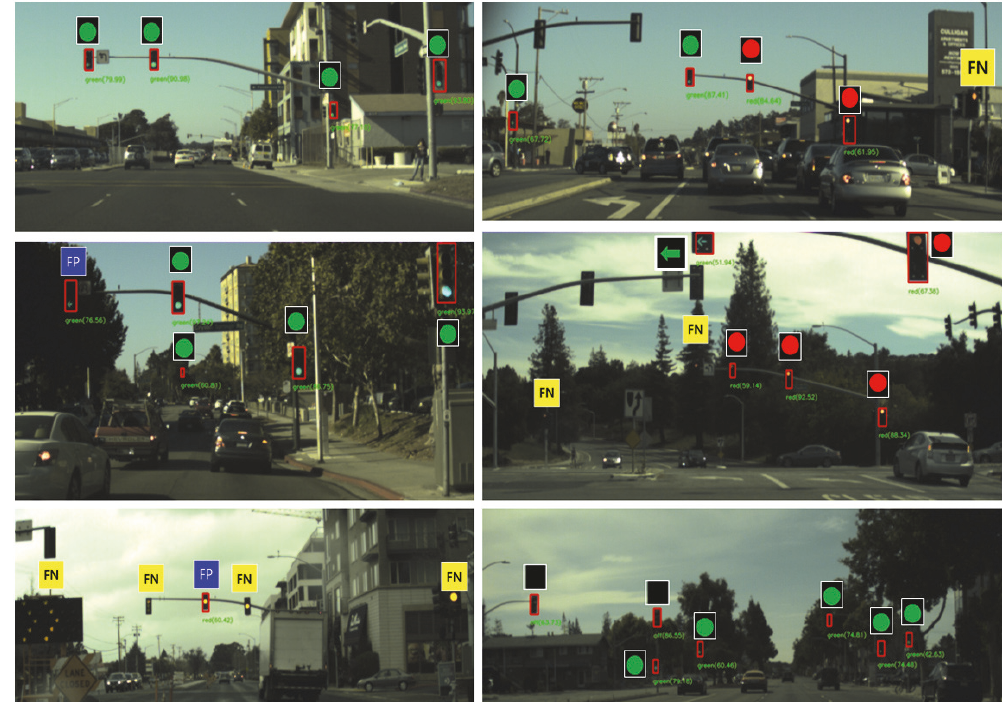
Figure 7: Traffic light detection examples of the second-ranked normalized RGB based Faster R-CNN model with